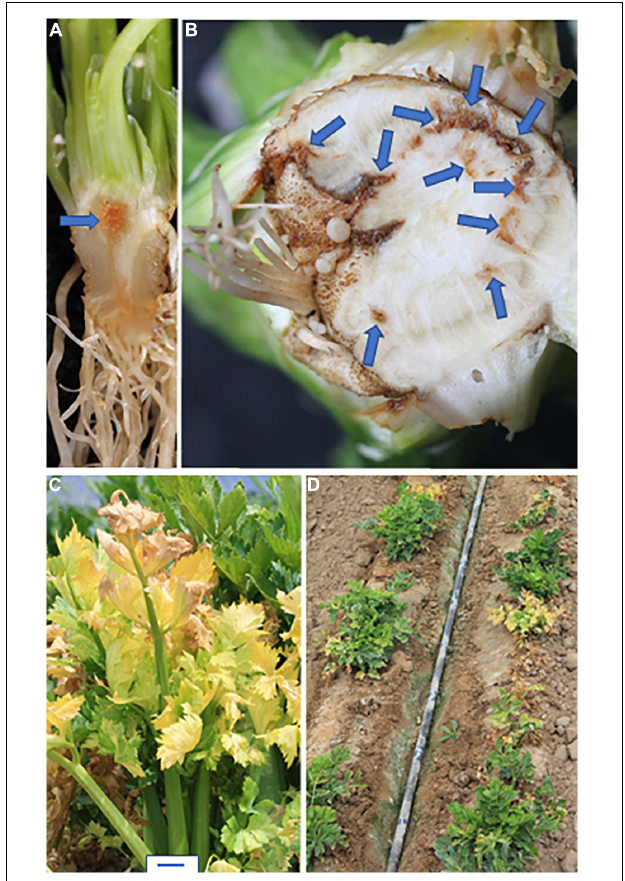
FIGURE 2 | Symptoms of F. oxysporum f. sp. apii ( Foa ) in celery. (A,B) Vascular discoloration in the crown (shown here) and roots. These plants were infected with Foa race 4. (A) In young transplants, the discoloration is orangish-brown. (B) In older plants, the discoloration is darker brown. This field-grown celery plant had vascular discoloration on more than 25% of the circumference of the crown and was severely stunted. (C) Chlorosis of older leaves, here caused by Foa race 2. (D) Death and severe stunting of young plants caused by Foa race 4. Size bar = 2 cm.